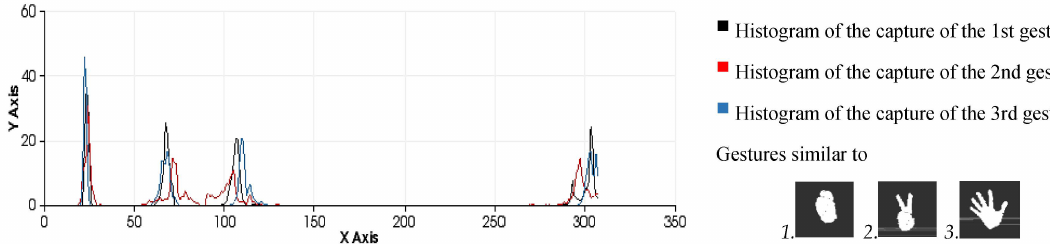
Figure 12. Similarity measures computed during the classification process among three different human-hand gestures: gesture 0, gesture 2 and gesture 5 p test 1 “ 81, test 2 “ 45, test 3 “ 87 q